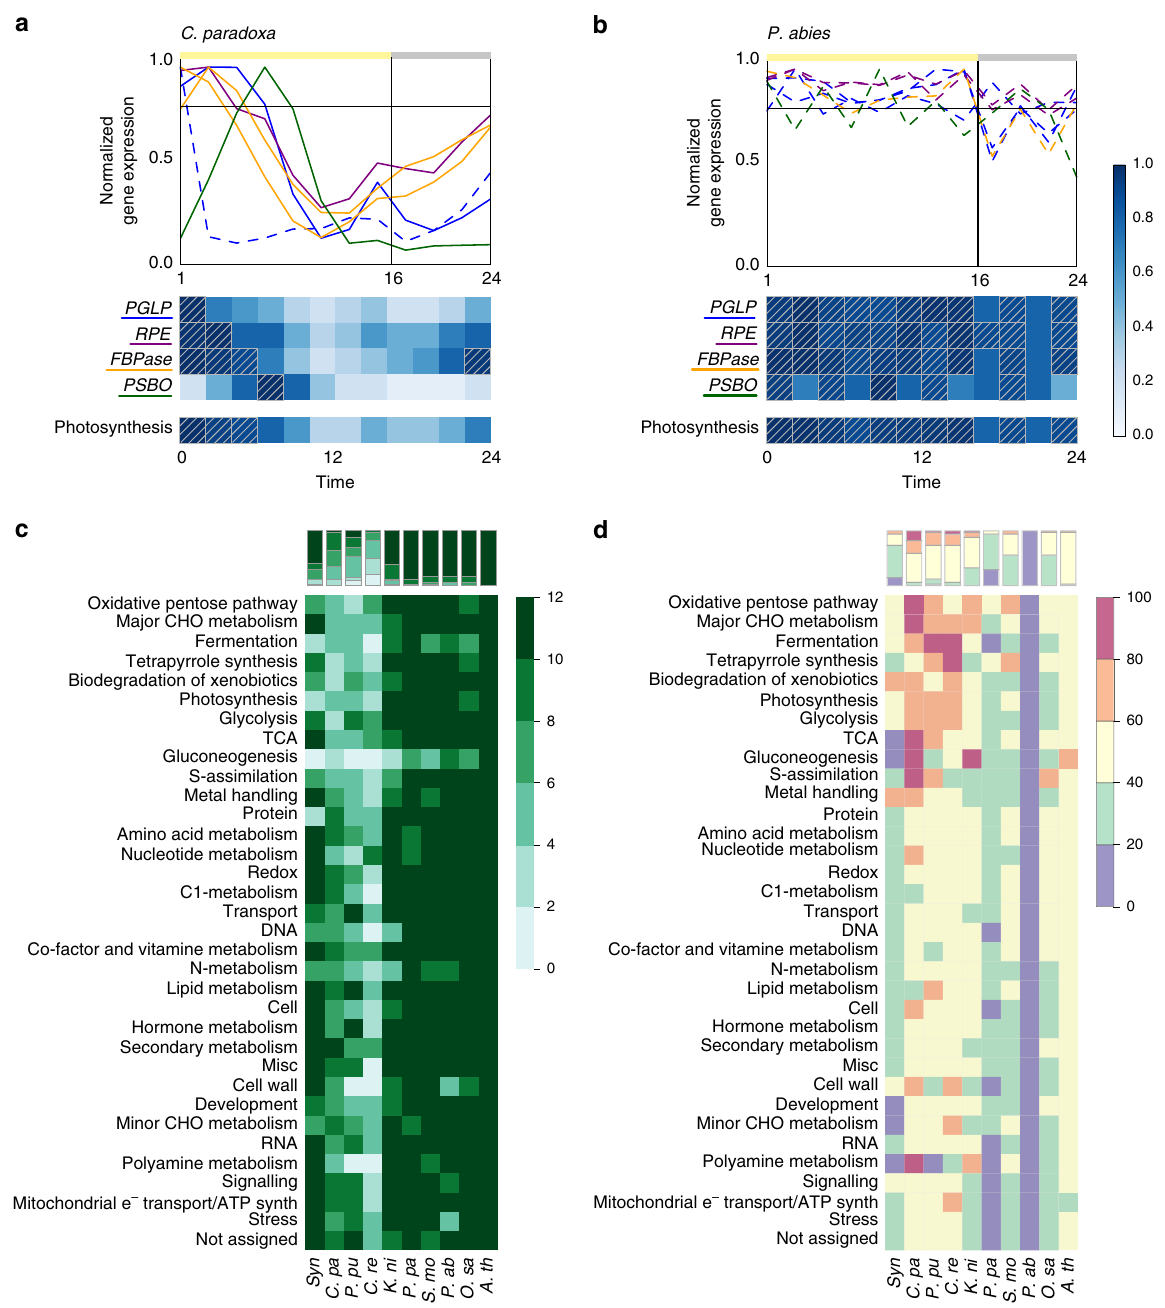
Fig. 4 Diurnal expression of biological processes. a Gene-expression pro fi les of C . paradoxa genes belonging to four families involved in photosynthesis. Solid lines indicate signi fi cantly rhythmic, while dashed lines indicate arrhythmic genes. The horizontal black line indicates the 80% expression threshold. The heatmap below the gene expression plot shows the average expression of the four gene families. Dashed squares indicate the average expression values higher than 80% at a given time point. b Gene-expression pro fi les of photosynthetic genes in spruce. c Expression speci fi city of biological processes. Rows indicate MapMan bins while columns indicate the species. The color intensity of the cells re fl ects the speci fi city of process expression, i.e., the number of time points where a bin is expressed above the average 80% of the maximum expression of the genes. d Percentages of rhythmic genes per biological process per species. The amounts are adjusted to ranges ( ≤ 20%, between 20 and 40%, between 40 and 60%, between 60 and 80% and >80%). The bars above both heatmaps summarize the processes